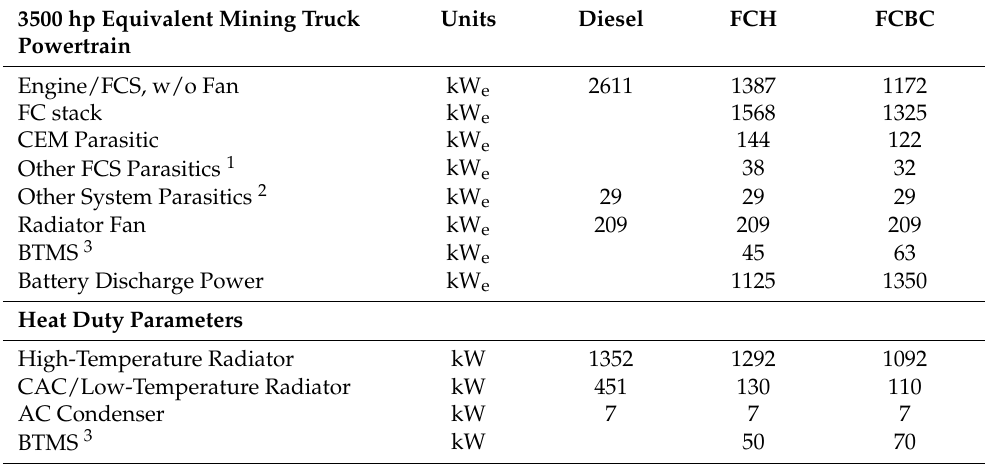
Table 3. Radiator heat loads, power sharing, and system parasitic sources at the rated power condition of 50 ◦ C ambient temperature. Thermal management systems for FCS and ESS are